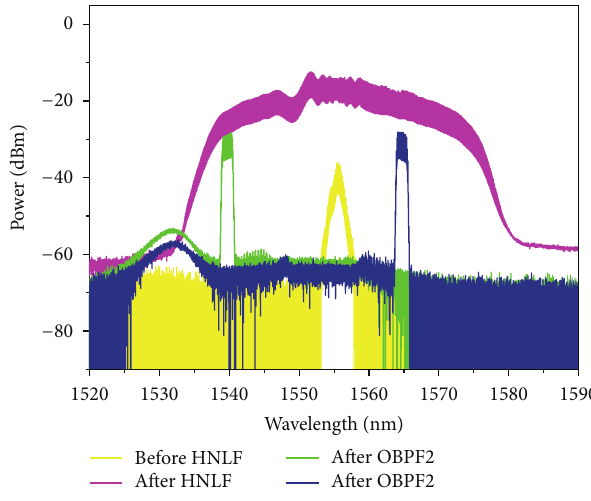
Figure 6: Optical spectrum measured at the input, the output of 700 m HNLF, and the output of